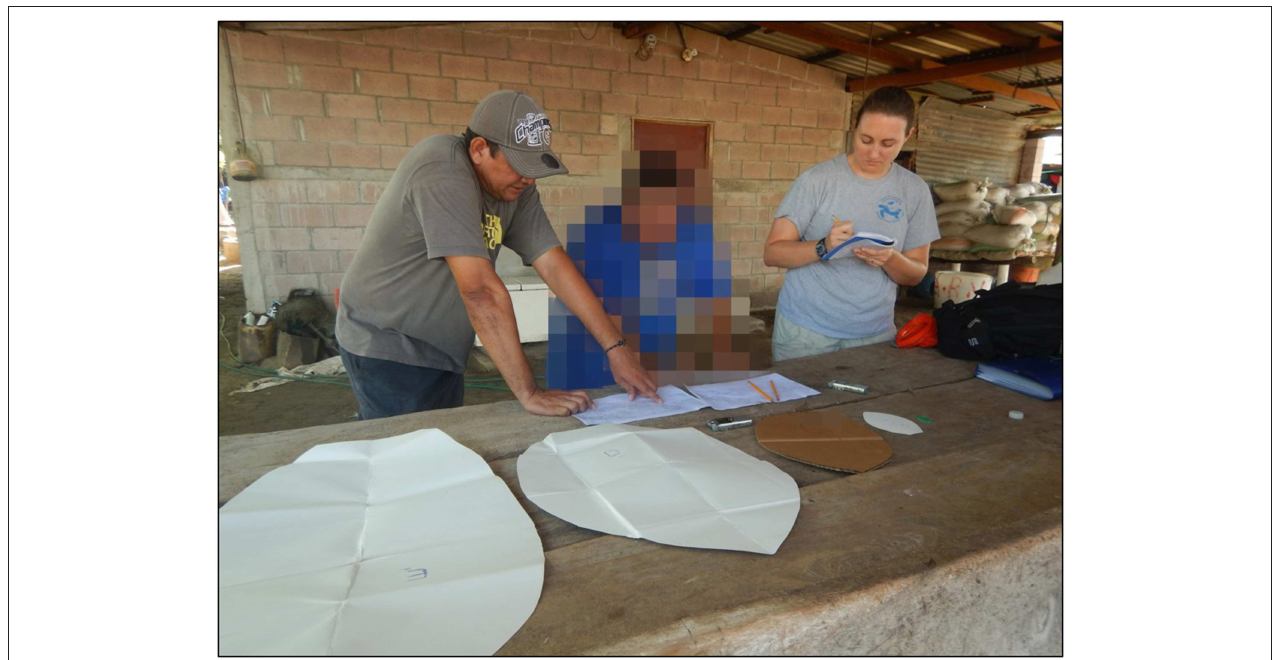
FIGURE 2 | RNS (left) , a fisher (middle) , and KRWS (right) work together on the participatory modeling activity. RNS and a fisher are marking on the map where hawksbill turtles have been seen within the estuary waters. Cardboard cutouts pictured from right to left are: A, hatchling, 4cm CCL; B, yearling, 15cm CCL; C, juvenile, 30cm CCL; D, subadult, 65cm CCL; E, nesting adult, 84cm CCL. Written informed consent was obtained from KRWS and RNS to include this picture in this manuscript.